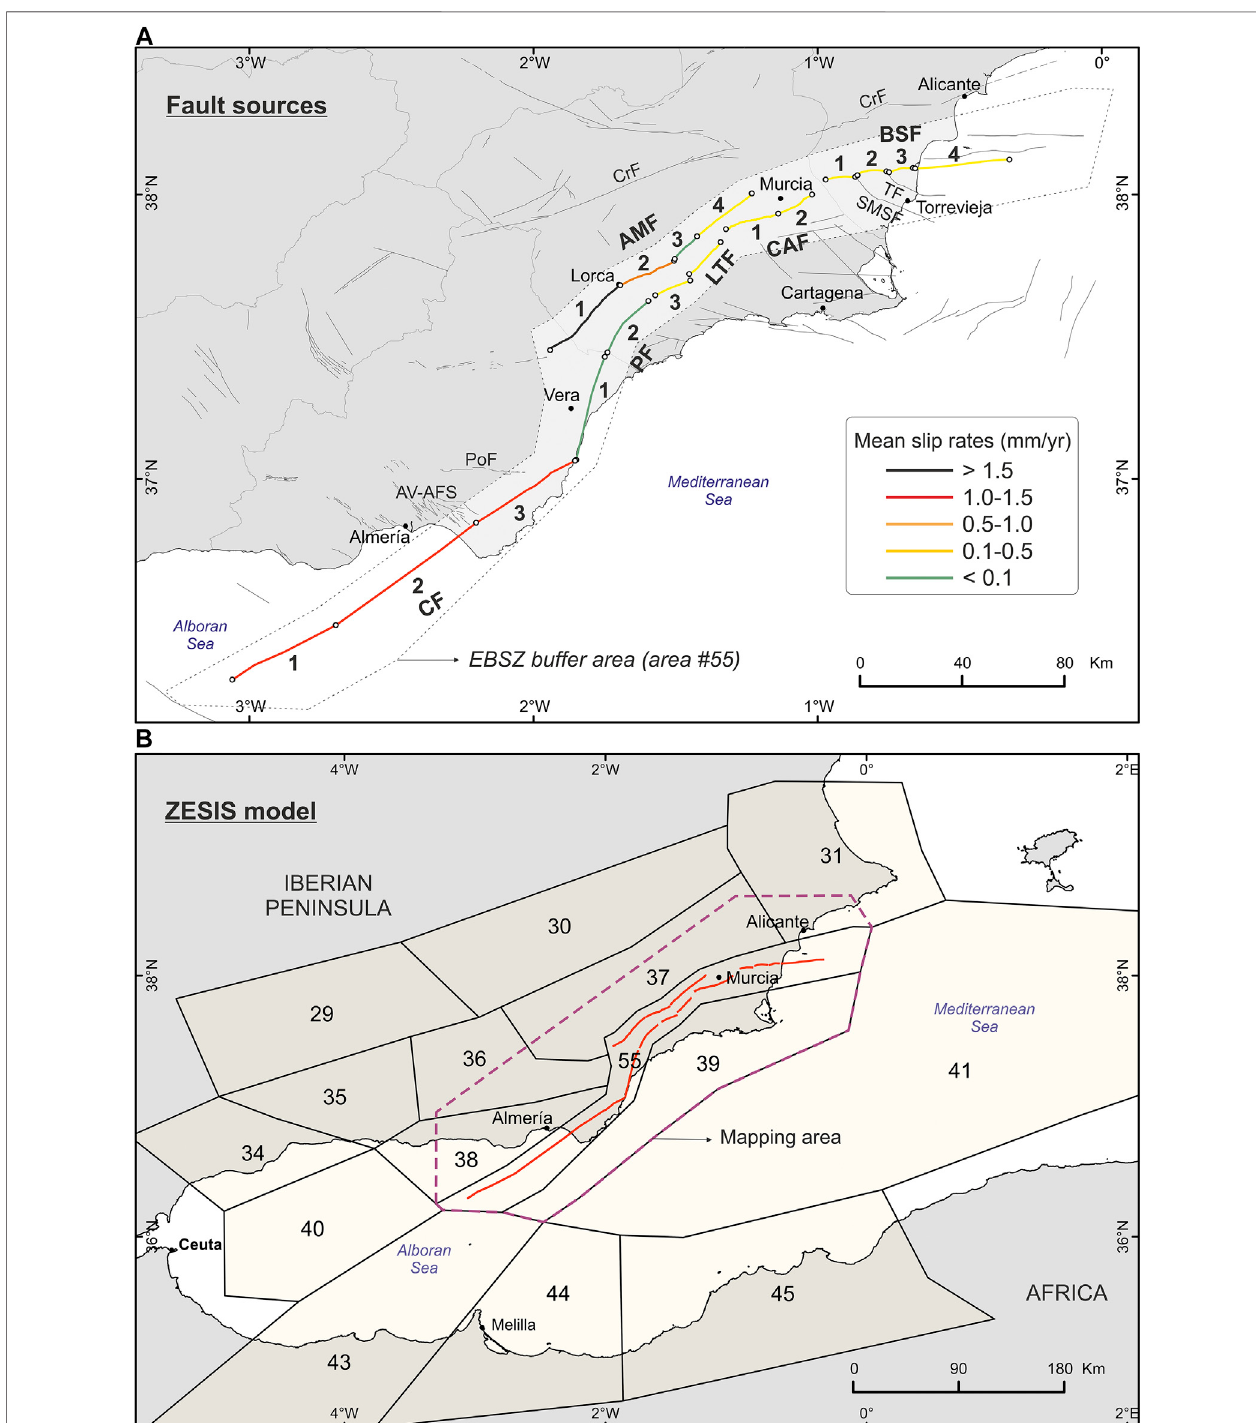
FIGURE 2 | (A) Simpli fi ed traces of the major faults of the EBSZ considered in the fault source modeling of this study. Each fault is marked by an abbreviation and each section ofthe respectivefaulthasa number assigned (ID). Theparameters ofeach faultID areindicated in Table 1 . CF: CarbonerasFault; PF: Palomares Fault; LTF: Los Tollos Fault;CAF:CarrascoyFault;BSF:BajoSeguraFault;AMF:AlhamadeMurciaFault.Thefaulttracesarepresentedfollowingacoloredscaleaccordingtotheirestimatedmeanslip ratevalues( Table1 ).Otherrelevantsecondaryfaultsnotincludedinthefaultsourcemodelingarealsoindicated.CrF:CrevillenteFault;SMSF:SanMigueldeSalinasFault; TF: Torrevieja Fault; AV-AFS: Andarax Valley and El Alquián Fault System; PoF: Polopos Fault. The buffer area of the EBSZ is indicated around the faults by a dotted line; (B) Seismogenic area sources considered in this study from the ZESIS model (IGME, 2015b; García-Mayordomo, 2015), whose parameters are indicated in Table 3 . A dashed purplelinedelineatesthemappingareawheretheseismichazardiscomputed.ThelocationofthemainfaultsoftheEBSZfrom Figure2A withinitsbufferarea(#55)areindicated.